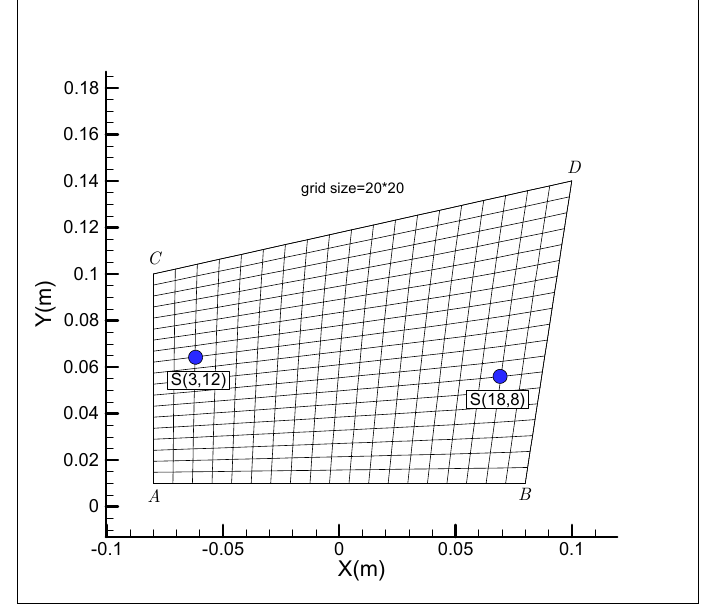
Figure 2. Two different places for the single sensor S , , used to measure the Figure 2. Two di ff erent places for the single sensor S , S ( 3,12 ) and S ( 18,8 ) , used to measure the t . temperature at time t i . temperature at time i